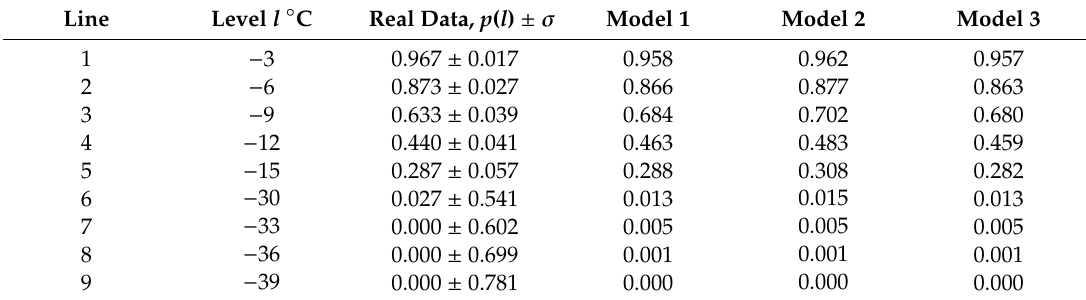
Table 4. Probability p ( l ) , Area 2, 5